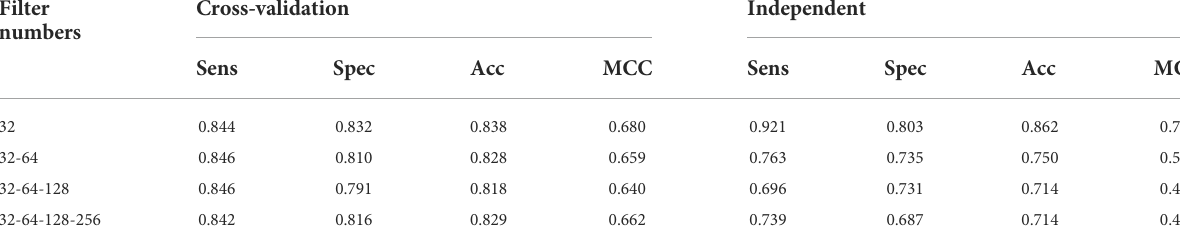
TABLE 3 Performance of the classi fi cation results for identi fi cation (UPP) using different fi lter layers. Filter numbers